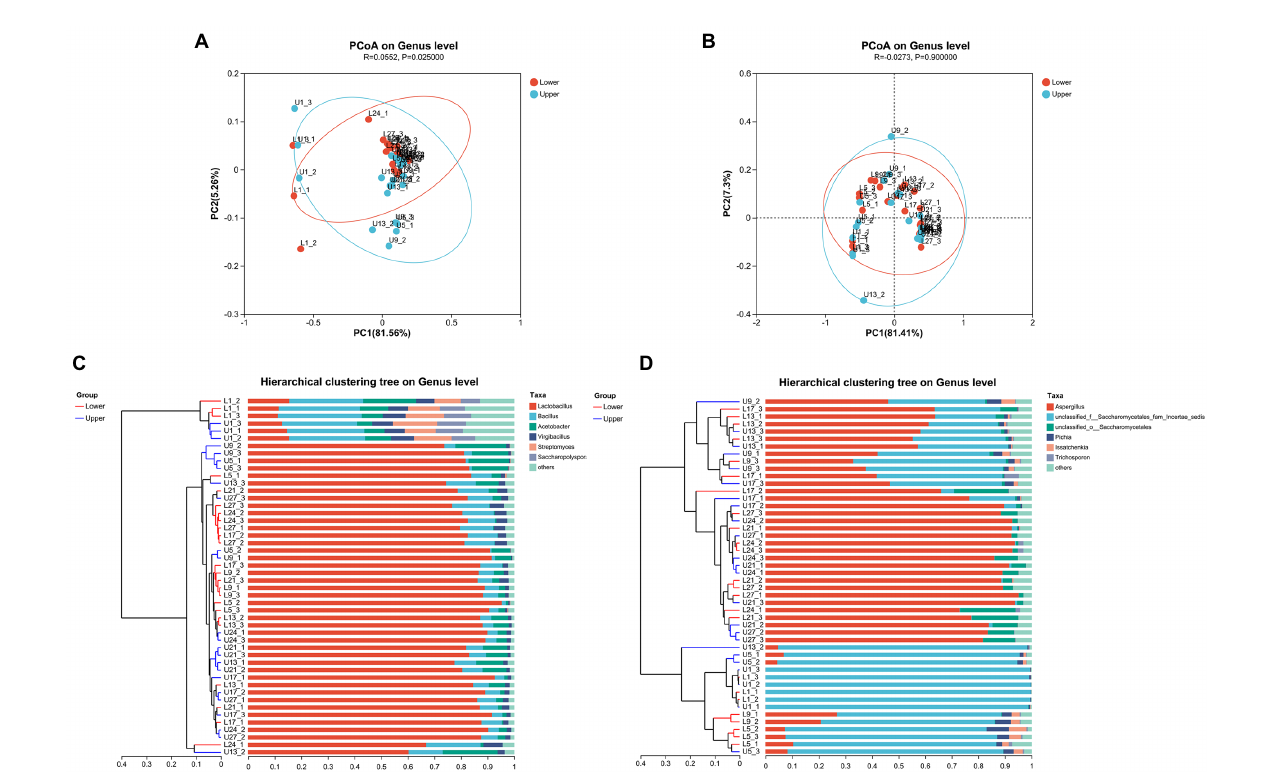
FIGURE 1 Principal coordinates analysis (PCoA) (A) and unweighted pair-group method with arithmetic mean (UPGMA) (C) analysis of bacterial community structure; PCoA (B) and UPGMA (D) analysis of fungal community